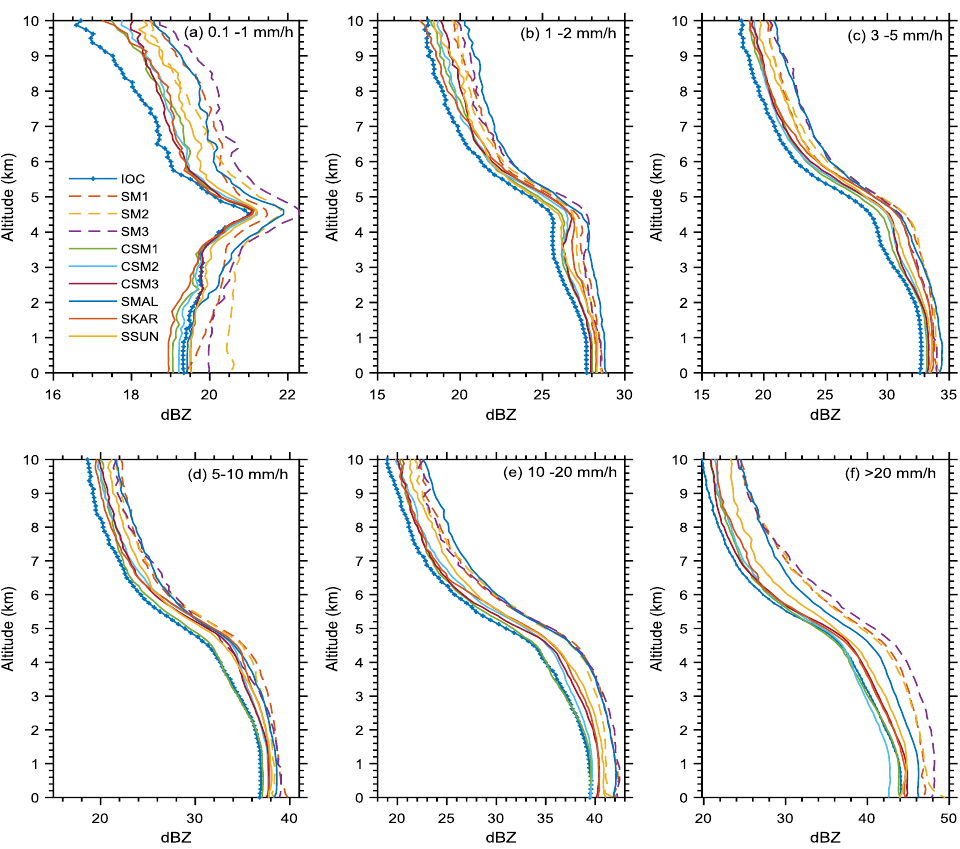
Figure 7. Vertical profile of reflectivity factor ( Z ) for ten selected locations of convective rain for a) very light rain, b) light rain, c) moderate rain, d) heavy rain, e) very heavy rain, and f) extreme rain.